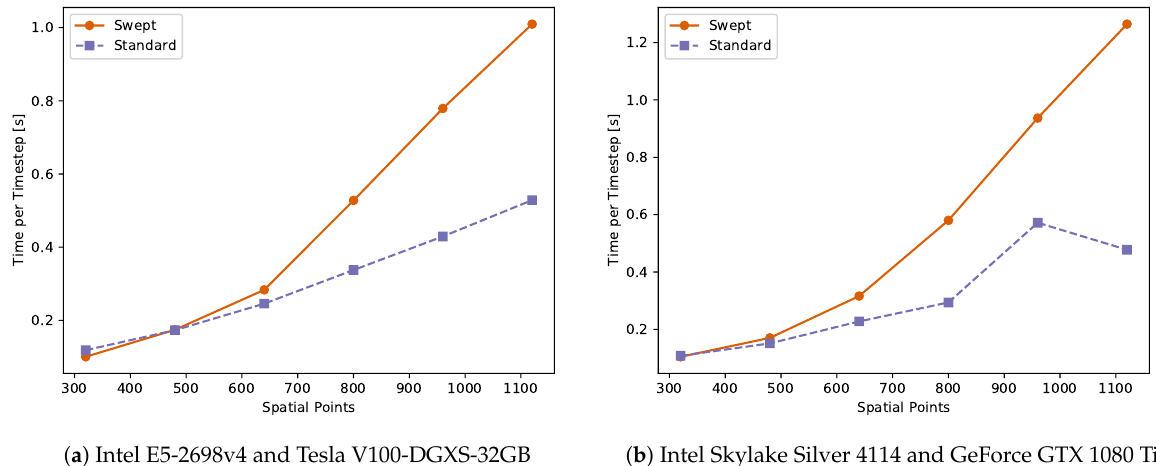
Figure 10. Time per timestep optimal performance for a given array size with a share of 100% solving the Euler